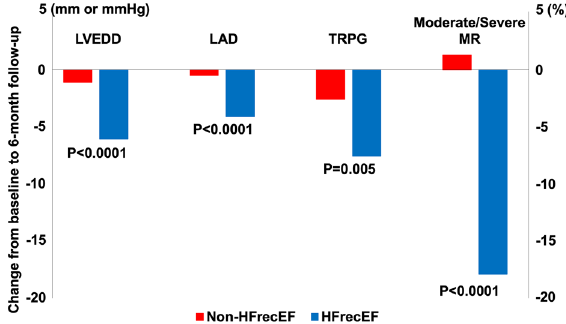
Figure 1. Changes in echocardiographic parameters from index hospitalization to 6-month follow-up echocardiography: HFrecEF versus non-HFrecEF. Figure made utilizing Microsoft Excel 2019, https:// produ cts. office. com/. Changes in each echocardiographic parameter are represented as mean values. LVEDD, left ventricular end-diastolic dimension; LAD, left atrial diameter; TRPG, tricuspid regurgitation pressure gradient; MR, mitral regurgitation; HFrecEF, heart failure with recovered ejection fraction.